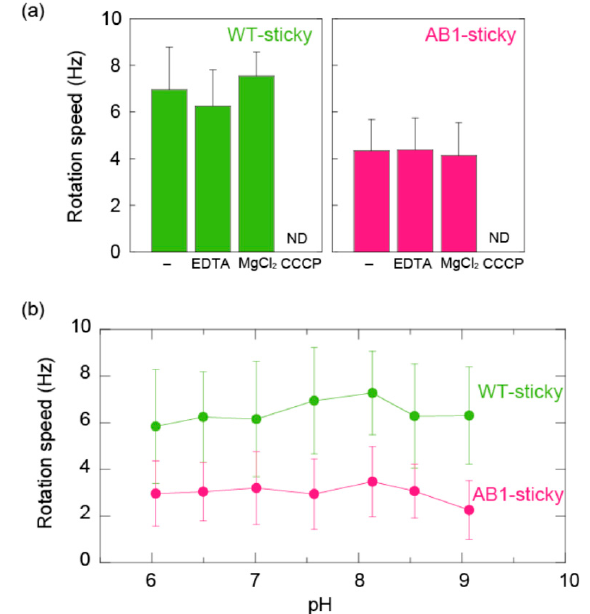
Figure 4. Rotational speed of single motors driven by MotA1 TCA /MotB1 TCA in B. subtilis . ( a ) Motor speeds of WT-sticky (left) and AB1-sticky (right) in 10 mM potassium phosphate buffer containing 0.1 mM EDTA. EDTA, MgCl 2 , and CCCP indicate buffers containing 10 mM EDTA, 10 mM MgCl 2 , and 10 mM MgCl 2 and 25 µM CCCP, respectively. ND represents that no spinning tethered cells were detected. ( b ) Effect of pH on the motor speed. 10 mM potassium phosphate buffer containing 10 mM EDTA was adjusted to the desired pH by titration with HCl or KOH.